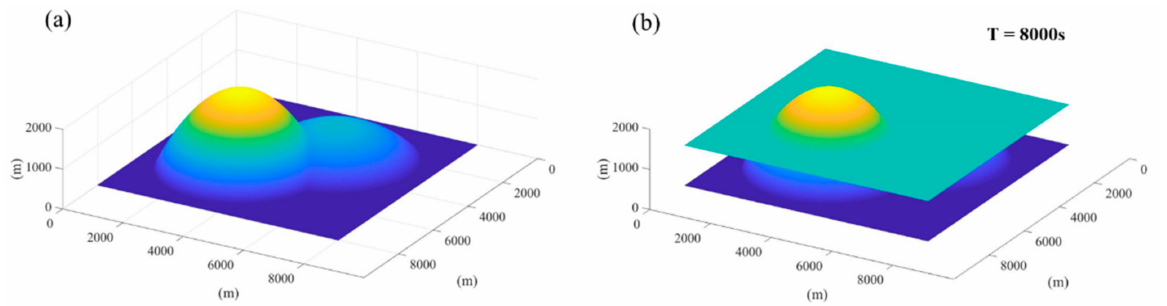
Figure 6. C-property checking for a static lake. ( a ) Lake geometry; ( b ) results after 8000 s.